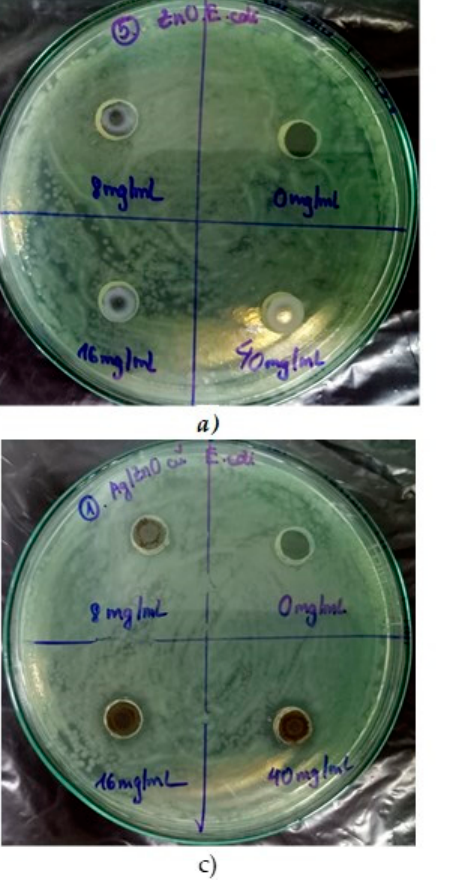
Figure 10. Photographs of antibacterial test against E. coli bacteria (agar-well diffusion method) for ZnO nanoparticles (( a ): without light irradiation; ( b ): under light irradiation) and Ag-loaded ZnO nanoparticles (( c ): without light irradiation; ( d ): under light irradiation). Table 3. Antibacterial activity against S. aureus bacteria of ZnO nanoparticles and Ag-loaded ZnO nanoparticles.